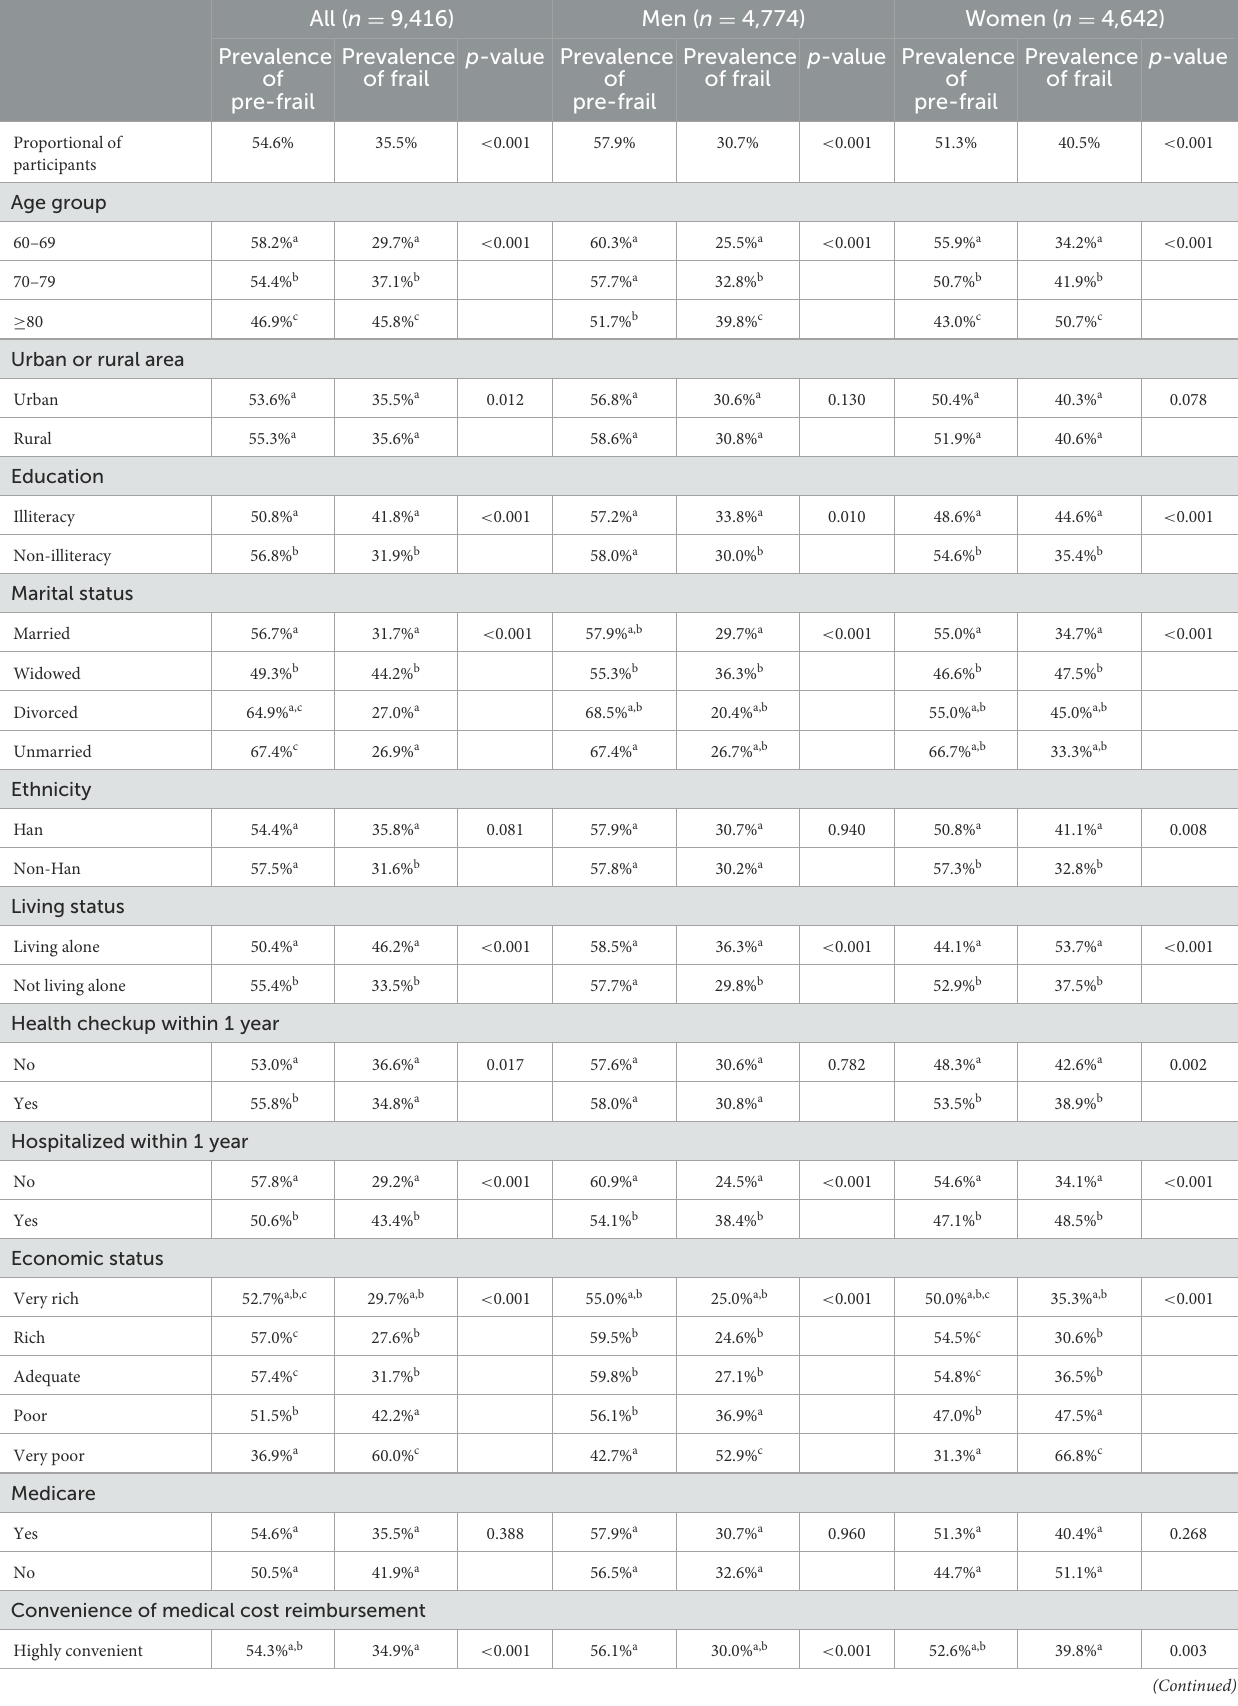
TABLE 2 Prevalence of frailty and pre-frailty among older adults with asthma in China in 2015.